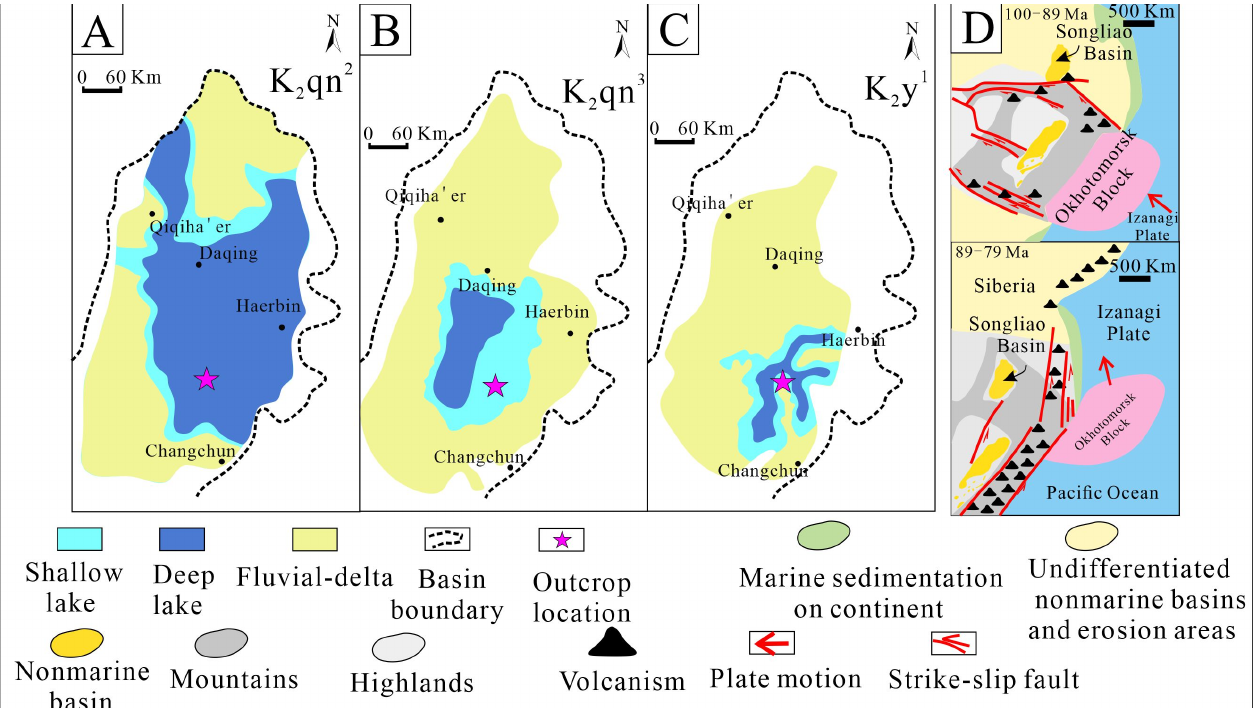
Figure 10. Depositional environmental variation in the Songliao Basin from the Qingshankou Formation to the overlying Yaojia Formation, showing shrinking of the paleo lake. ( A ) Paleo Songliao lake range in K 2 qn 1 . ( B ) Paleo Songliao lake range in K 2 qn 3 . ( C ) Paleo Songliao lake range in K 2 y 1 . ( D ) Evolution of Okohotomorsk Block and relationship with the Songliao Basin in East Asia during 100 to 79 Ma (modified from [26,28,31] ).